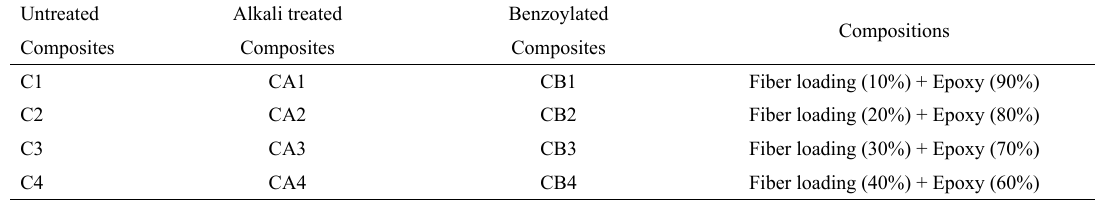
Table 1. Designation and detailed composition of the composites Untreated